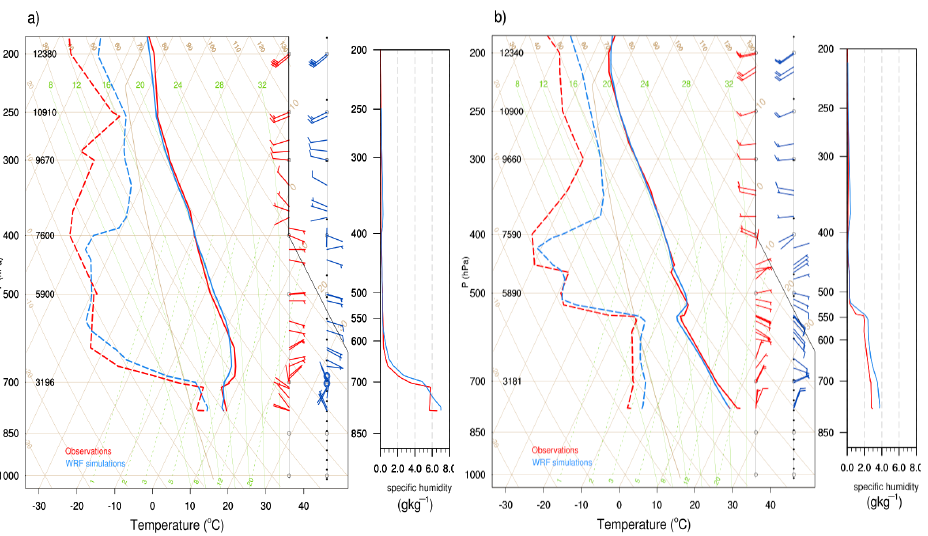
Figure 4. Skewt diagrams for February 10, 2017 at ( a ) 0600 LST and ( b ) 1800 LST. In color red the vertical profile of observed temperatures ( ◦ C) and horizontal wind vectors in m s − 1 (right columns). In blue the corresponding CTRL simulation variables. The right-most column panels shows the vertical profile of specific humidity (g kg − 1